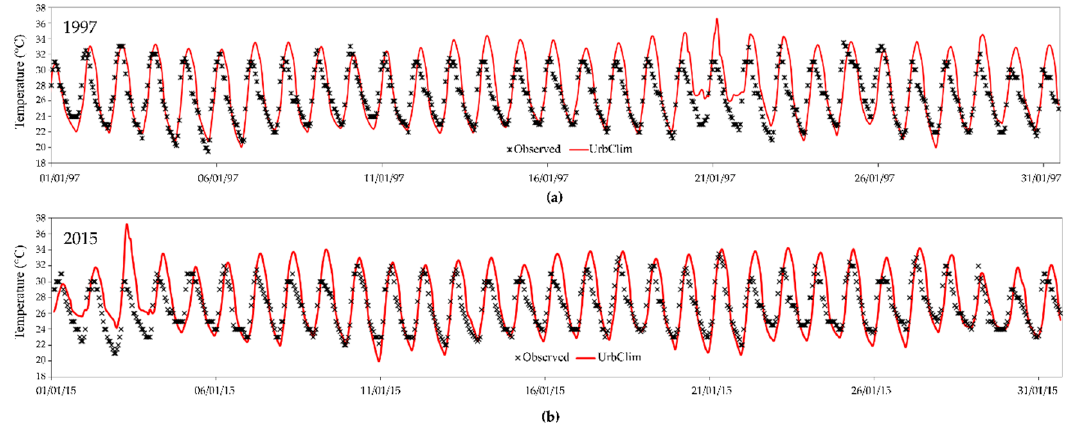
Figure 3. Simulated and observed daily time series 2 m air temperature of January ( a ) 1997; ( b ) 2015.